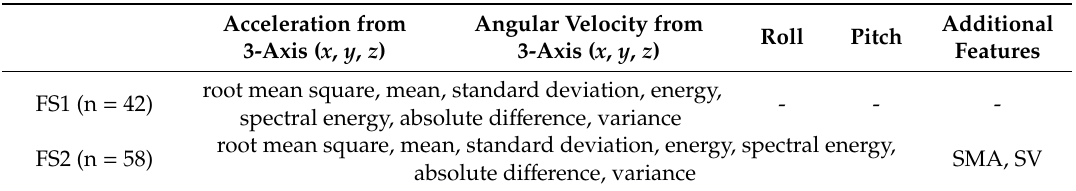
Table 3. Description of feature